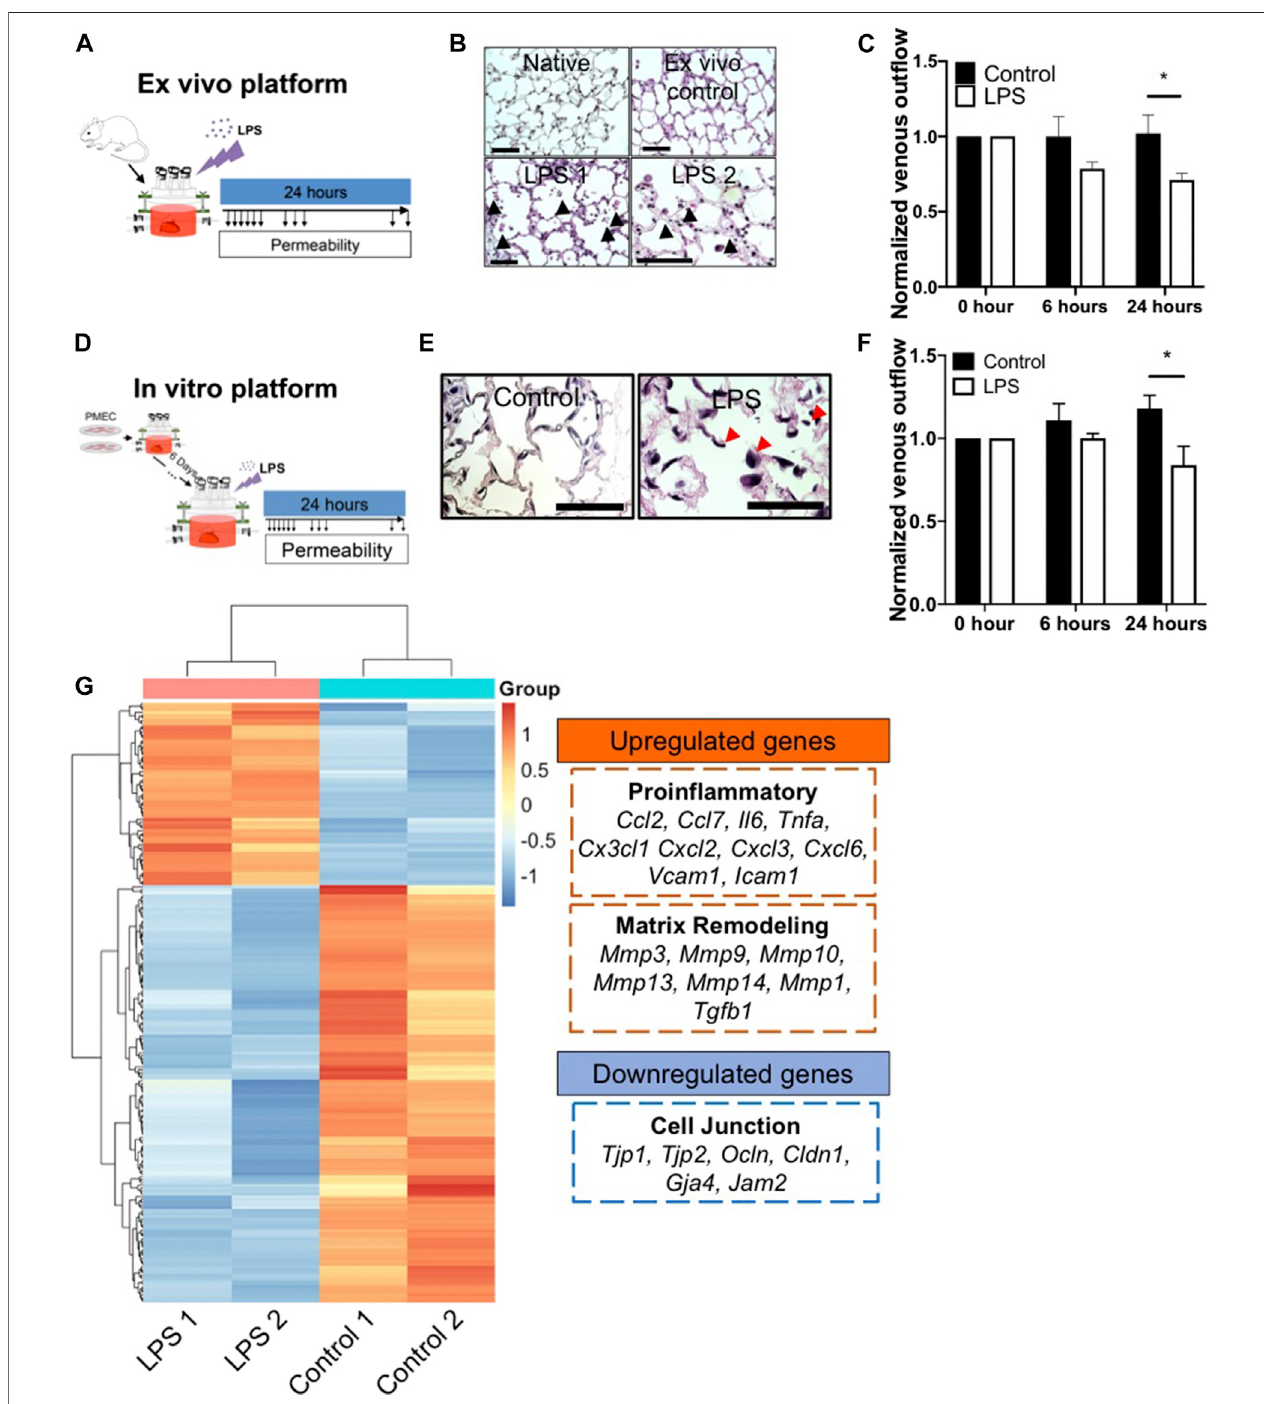
FIGURE6| The exvivo and invitro platformtomodelLPS-inducedin fl ammation. (A) Schematicofwork fl owforthe exvivo platform. (B) RepresentativeH/Eimages of lung tissues from native, ex vivo control, and ex vivo LPS samples. Arrows indicate cell death, matrix breakdown, and interstitial puf fi ng. Scale bar indicate 75 μ m. (C) Venous out fl ows in the ex vivo platform with or without LPS treatment, n (cid:1) 3. (D) Schematic of work fl ow for the in vitro platform. (E) Representative H/E images of lung tissuesfromcontrolandLPS-treatedrepopulatedlungs.Arrowsindicatecelldetachmentandocclusioninthepulmonaryvasculature.Scalebarindicate75 μ m. (F) Venous out fl ows in the repopulated lung control, and repopulated lung LPS conditions, versus time, n (cid:1) 3. (G) Heatmap of top differentially (adjusted p < 0.05 and log2foldchange > 3 or < − 3) expressed genesbetween control and LPS-treated repopulated lungs, normalized acrosseach gene toshow up-regulation (red) and down- regulation (blue) as compared to the other group. The representative upregulated and downregulated genes after LPS treatment as compared to control without LPS were listed. * indicate p < 0.05. There were 3 – 4 replicates performed in each sample.